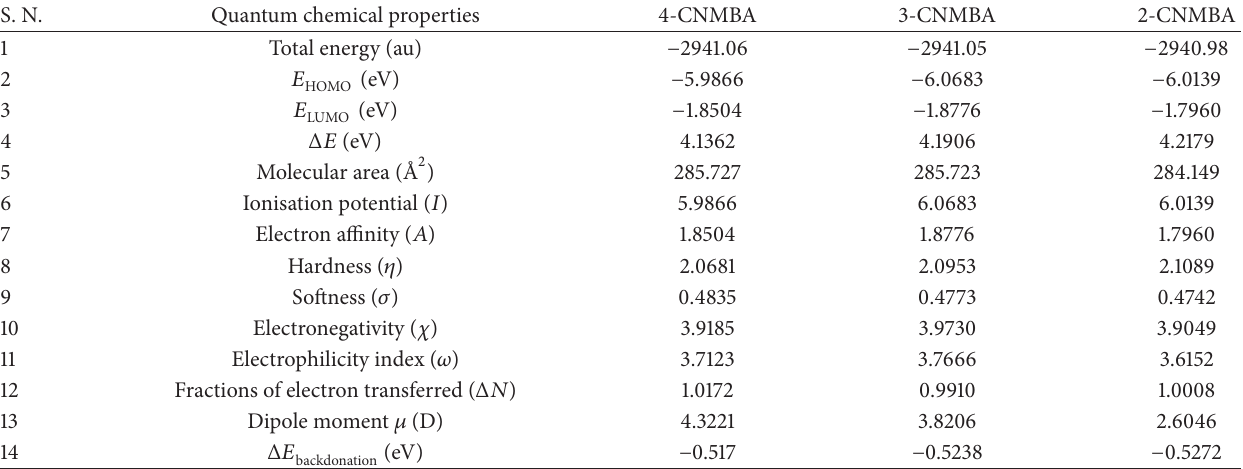
Table 2: The calculated quantum chemical parameters for studied inhibitors obtained with the DFT at the B3LYP/6-31+G(d) method. S.